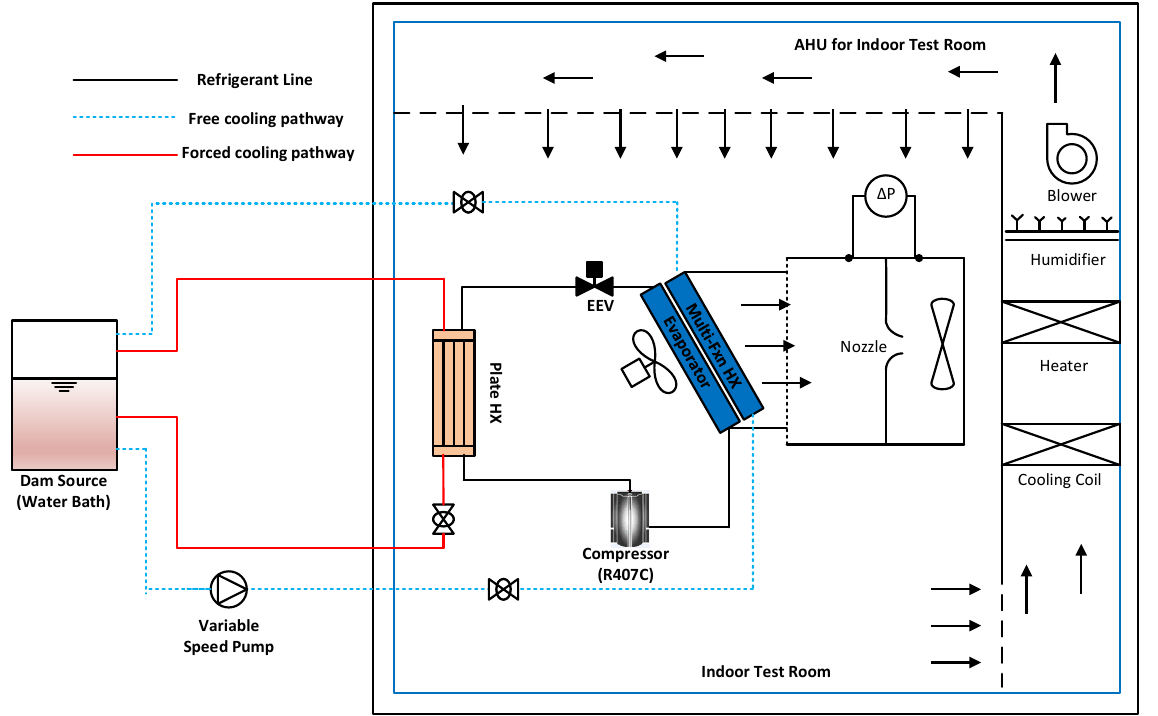
Figure 2. Schematic diagram for a hybrid cooling system that uses dam water for data